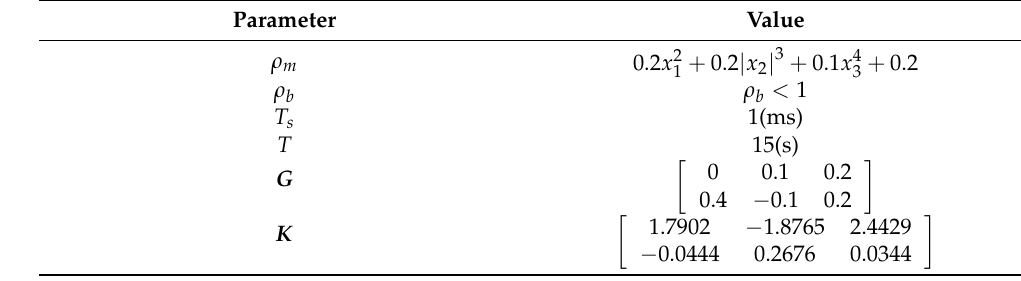
Table 1. Parameter